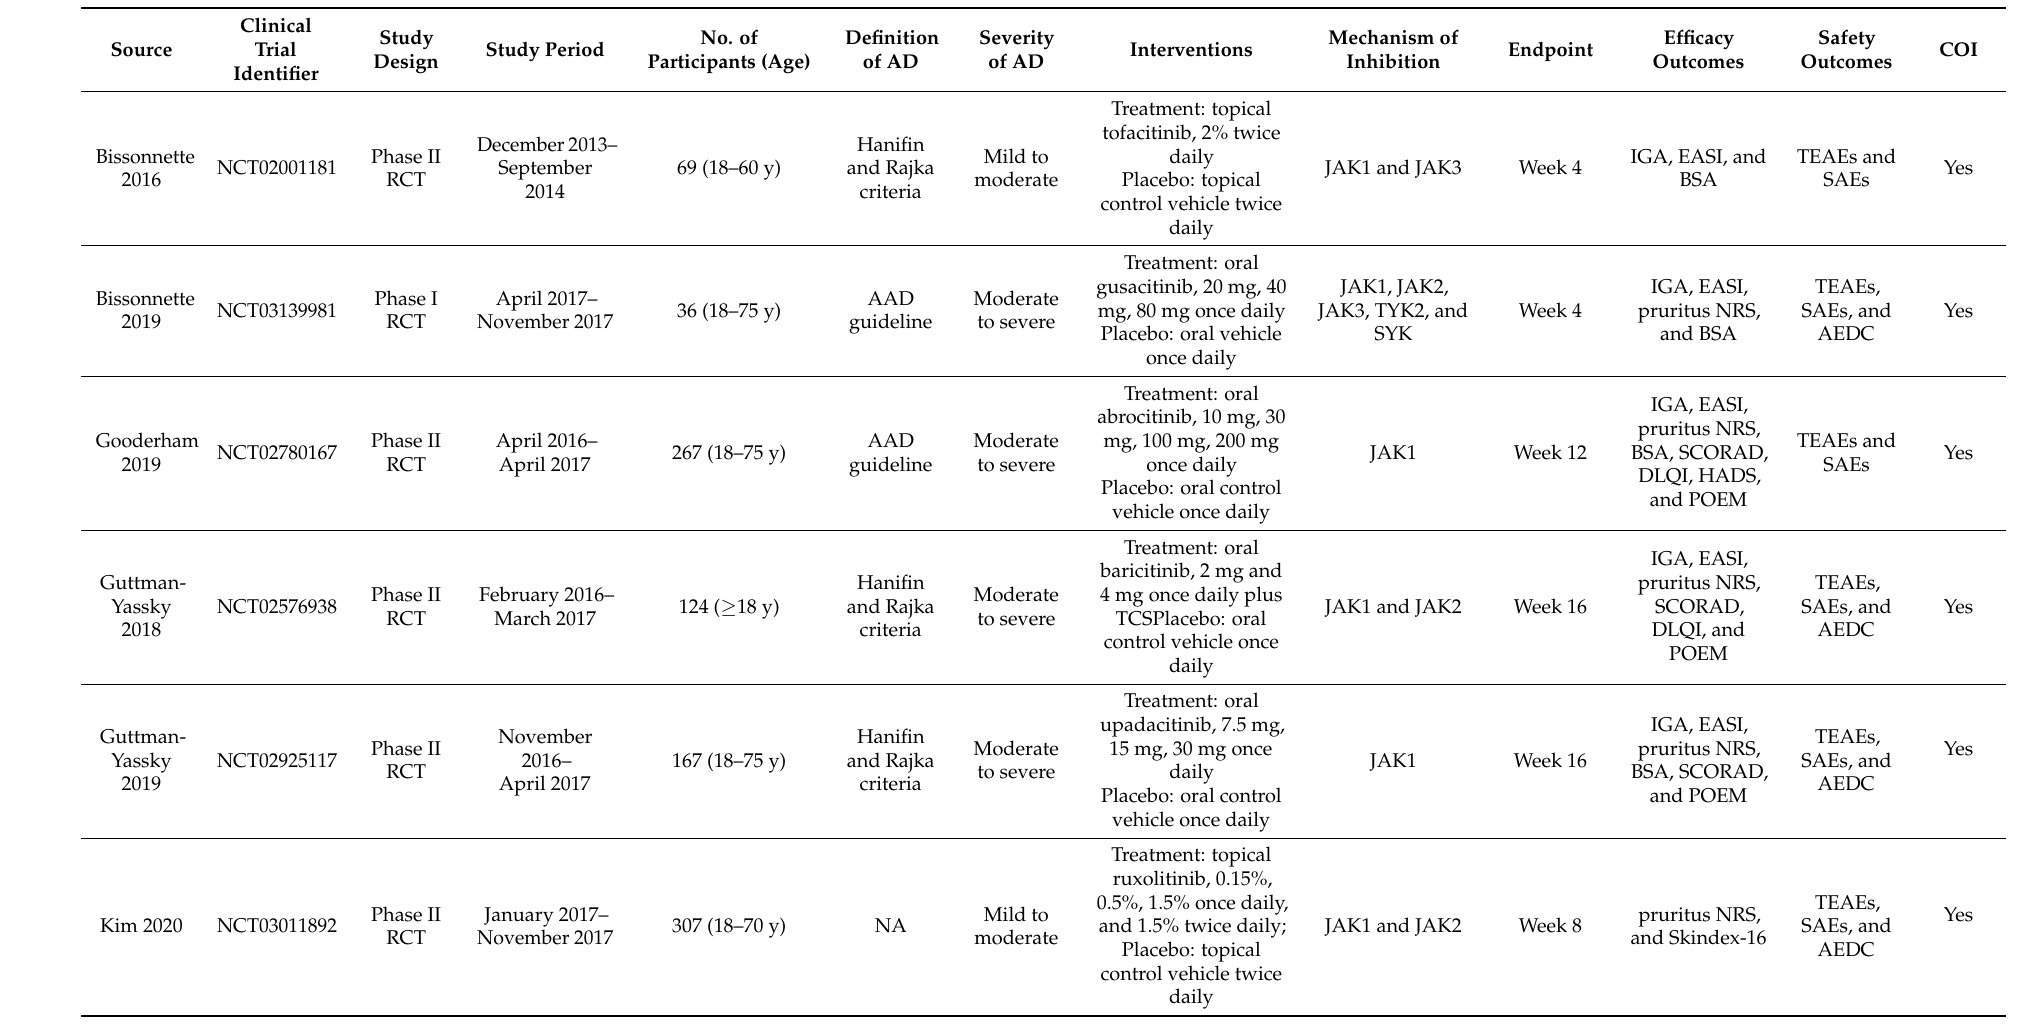
Table 1. Characteristics of studies included in the